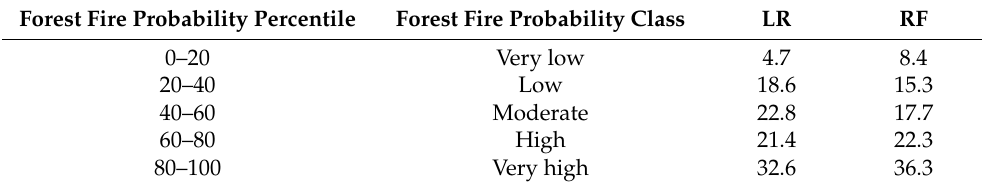
Table 4. Forest fire distribution (%) across different probability classes based on LR and RF models for the validating set of